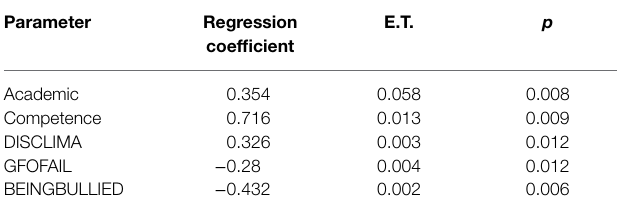
TABLE 8 | Results (regression coefficients and significant effects) for social